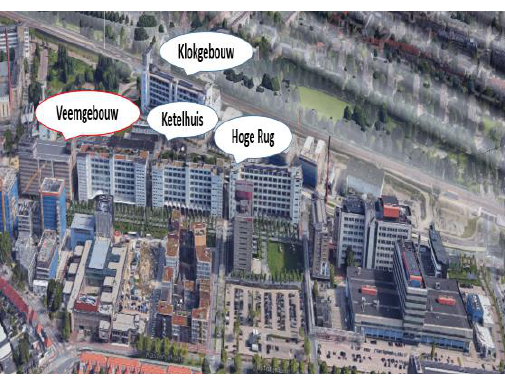
Figure 3 Map of Eindhoven